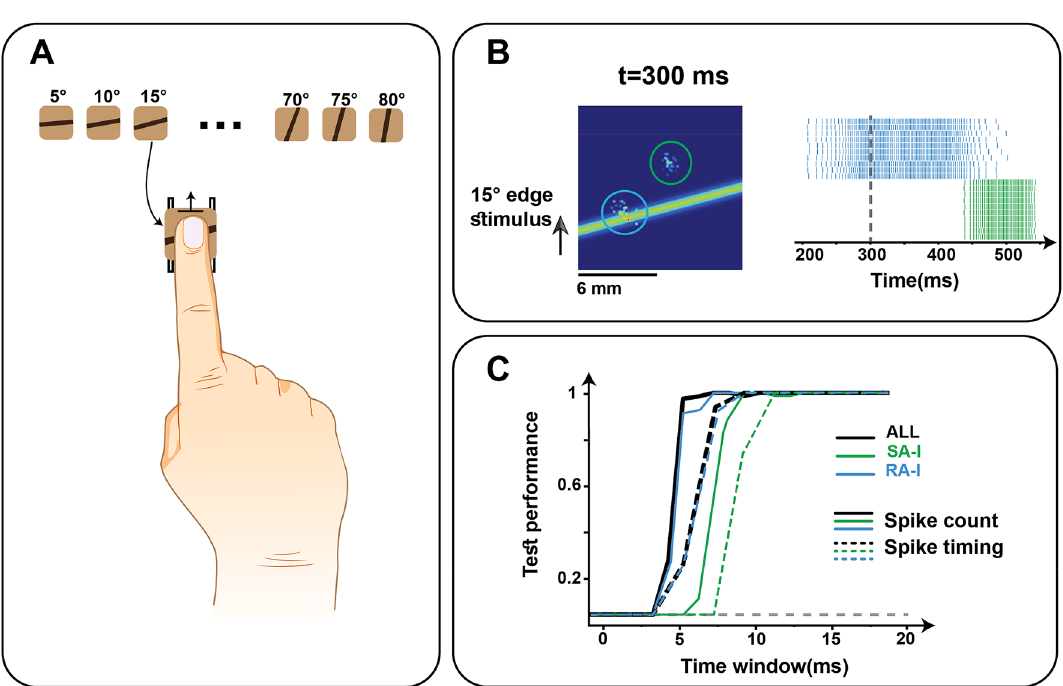
Figure 4. Decoding the orientation of a scanned edge. ( A , Upper) The 16 edge orientation stimuli (5°–80° in 5° steps). ( A , Lower) Simulated scanning edge experiment: The fingertip makes contact with the edge oriented at 15° and then the edge is moved upwards. ( B , Left) Sampled mechanoreceptors which are innervated by two afferents (green circle shows the SA-I receptive field and blue circle indicated the RA-I one) and scanned edge moves across the receptive fields. In this way, the activated mechanoreceptors generate spiking responses in their corresponding fibers. ( B , Right) Responses of 2 selected SA-I and RA-I fibers to the scanned edge stimulus for 10 repetitions. The SA-I and RA-I firing responses are depicted in green and blue, respectively. The vertical dashed line represents the time of edge location shown in ( B , Left). ( C ) Classification performance for each afferent type (green and blue) and both (black) for different time windows using spike count (solid curves) and temporal metric (dash curves). The horizontal gray dashed line denotes the chance